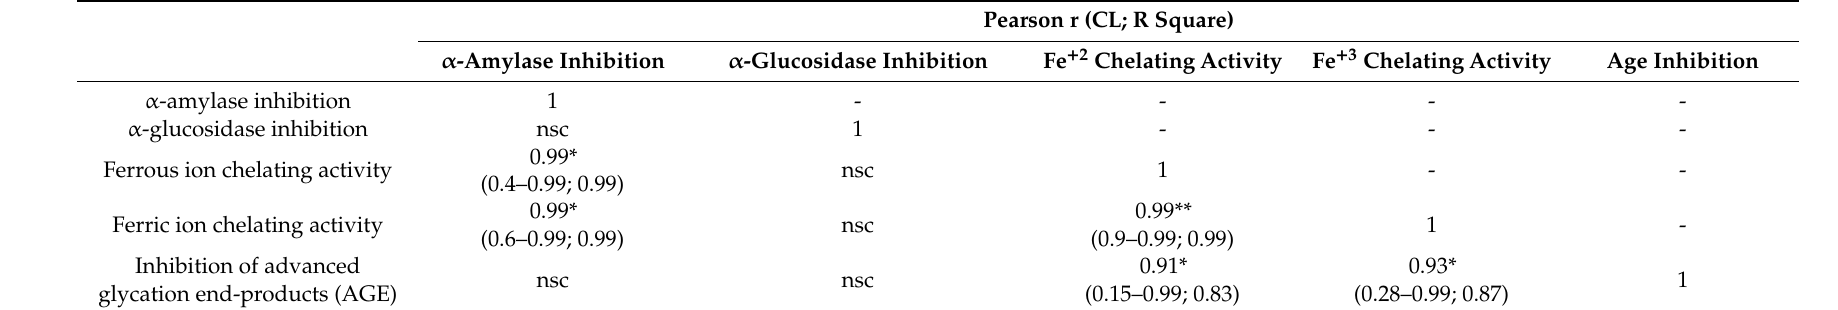
Table 4. Pearson correlation coe ffi cient among biological activities of